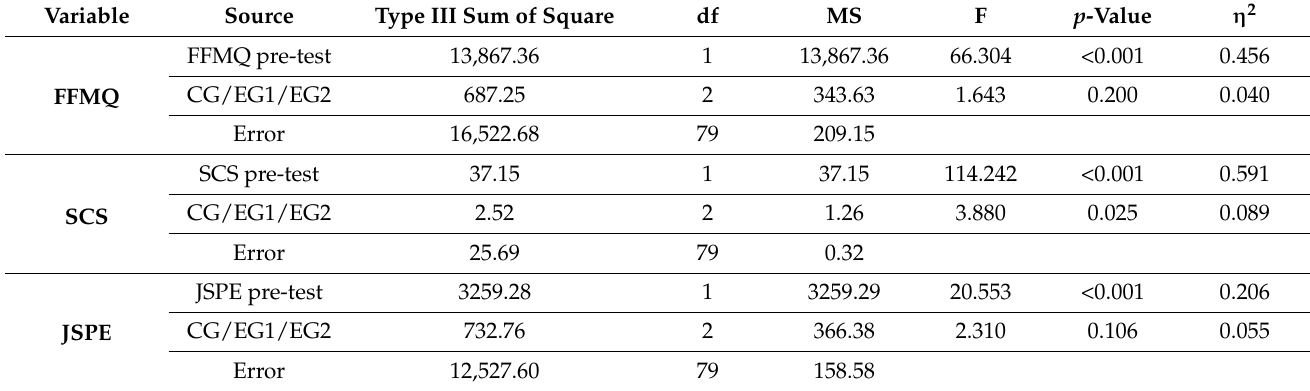
Table 5. Comparison between groups in follow-up scores, controlling pre-test scores, using